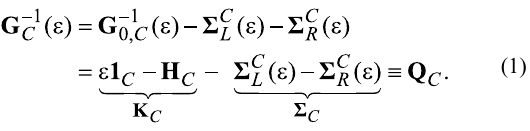
tions, the retarded Green’s function of the central region, G C , linked to biased ( V ≠ 0) electrodes is related to the retarded Green’s function of the isolated system, G 0, C = ( ε − H C ) − 1